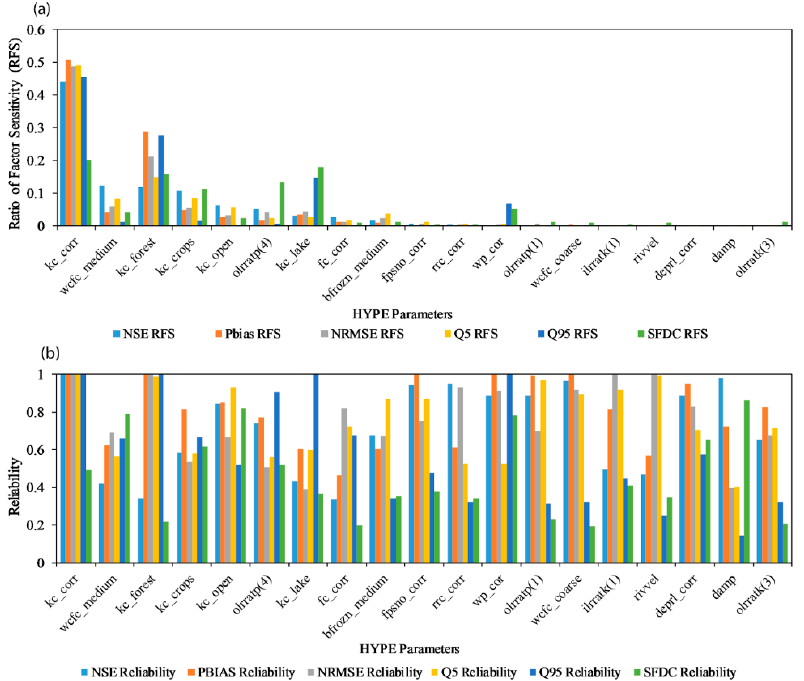
Figure 5. ( a ) Ratio of Factor Sensitivity and the ( b ) reliability of parameters based on a long-term sensitivity analysis (1981–2010) using Variogram Analysis of Response Surfaces (VARS) and different evaluation criteria for NCRB .